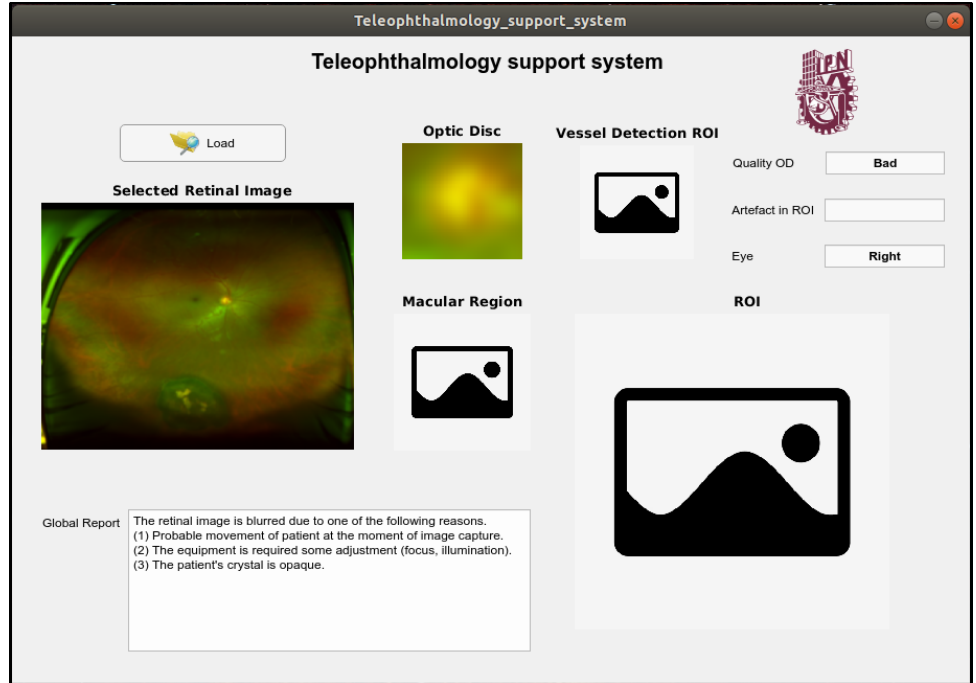
Figure 17. An example of output of the support system when the input image is inadequate quality. We measured the processing times of each case for the proposed ophthalmology support system. and 32 GB of RAM. The Table 10 shows the average elapse times. It is worth noting that these processing quality, it takes approximately 11.3